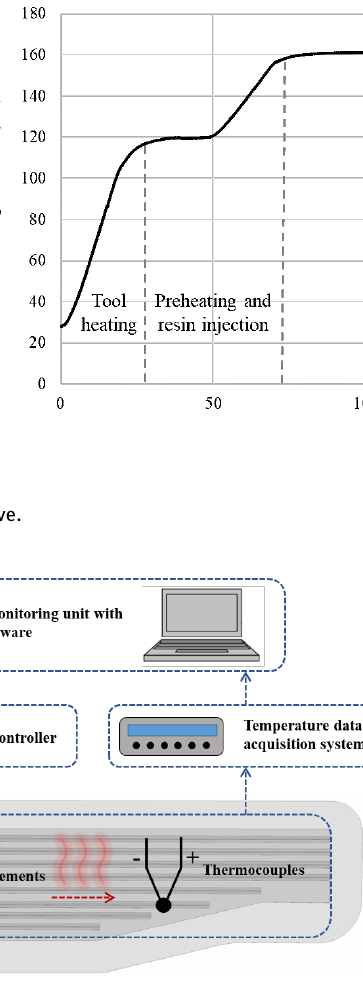
Figure 6: Overall system description of the thermal management system.